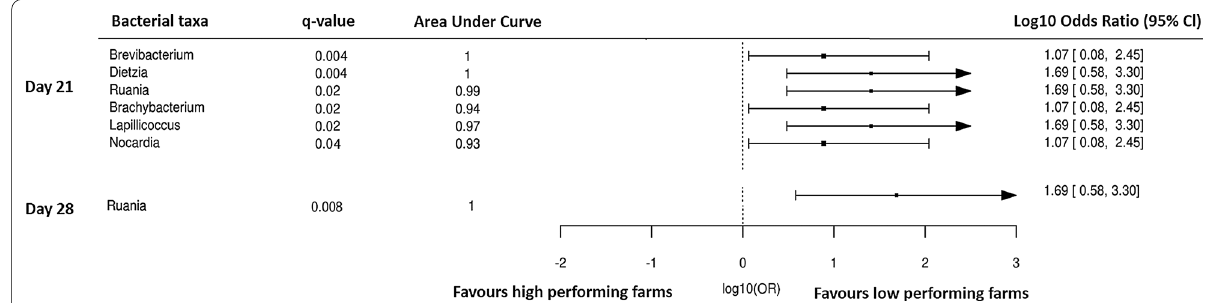
Fig. 6 Forest plot of the significantly different bacterial taxa (Wilcoxon q value < 0.05) of company A farms in dust with AUC left of the vertical dotted line (line of no effect) denote the increased chance of occurrence of microbiota towards high‑performing farm and the results to the right of the vertical dotted line denotes the increased chance of occurrence of microbiota towards the low‑performing farm